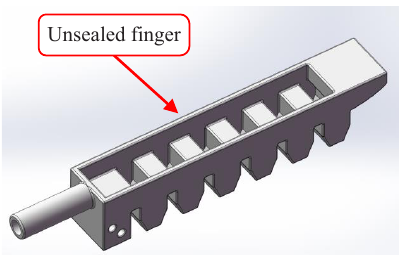
Figure 3. Unsealed finger.